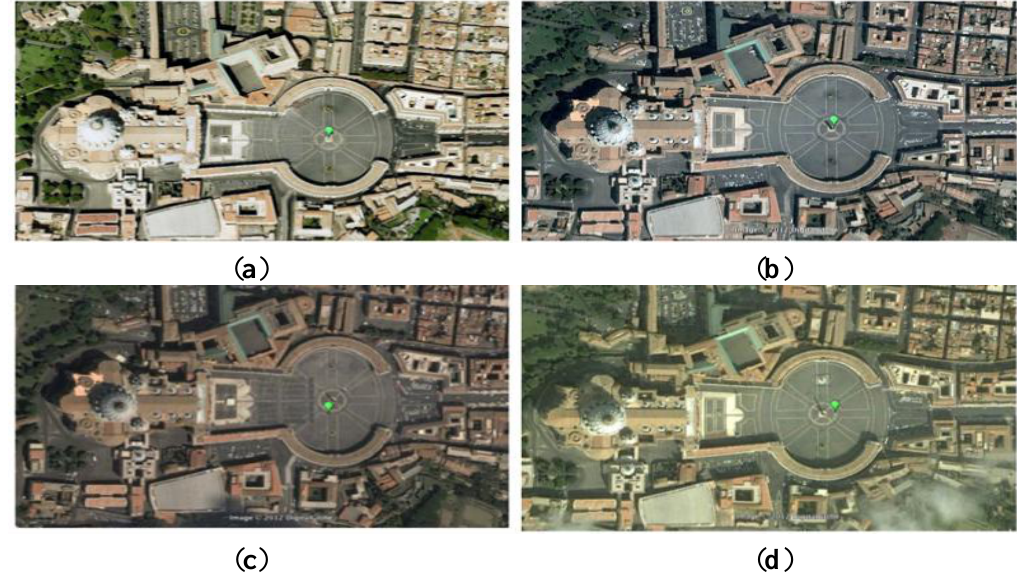
Figure 1. Archived Google Earth © imagery of St. Peters Square, Vatican City. ( a ) 2007 reference image; ( b ) 2005 image 5-m different; ( c ) 2004 image 24-m different; ( d ) 2002 image 19-m